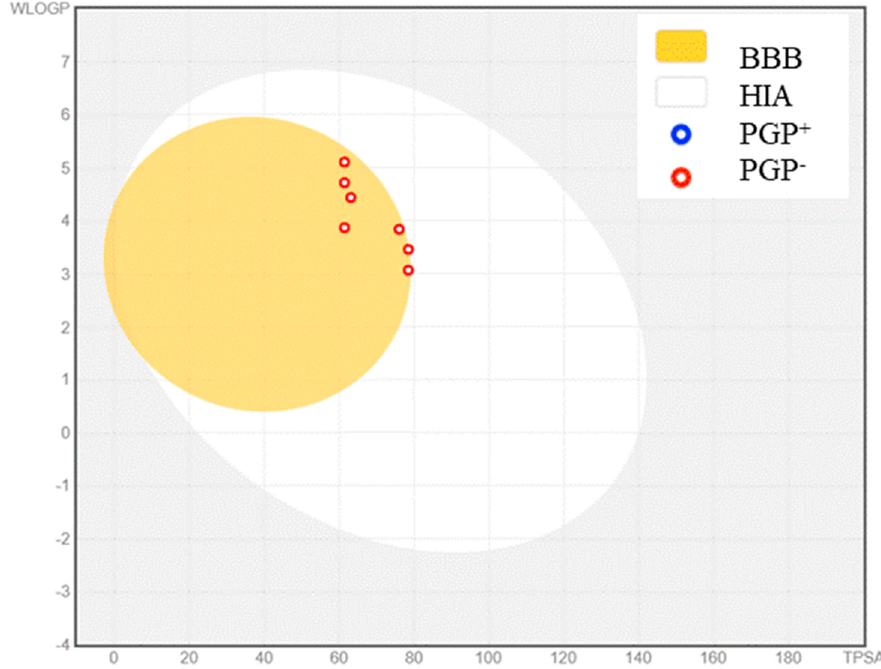
Figure 2. BOILED-Egg model of L 1–7 to predict gastrointestinal absorption and BBB penetration. (HIA—human gastrointestinal absorption; PGP + —substrate of P-glycoprotein; PGP − —non-substrate of